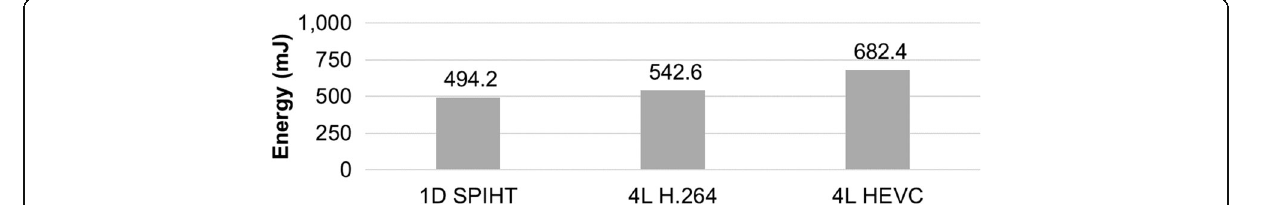
Fig. 2 Energy comparison of 1D SPIHT, 4L H.264, and 4L HEVC